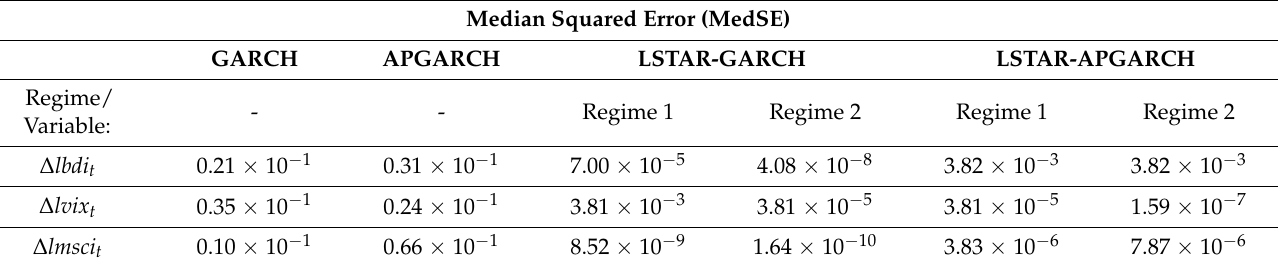
Table 7. Out-of-Sample Forecast